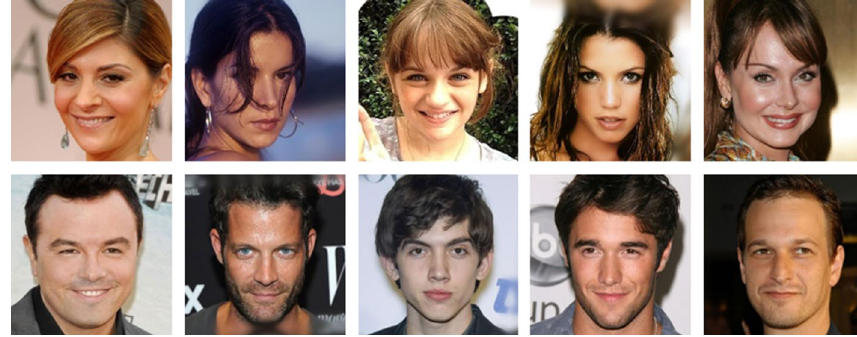
Fig. 4 Samples of ground‑truth images from “CelebA”